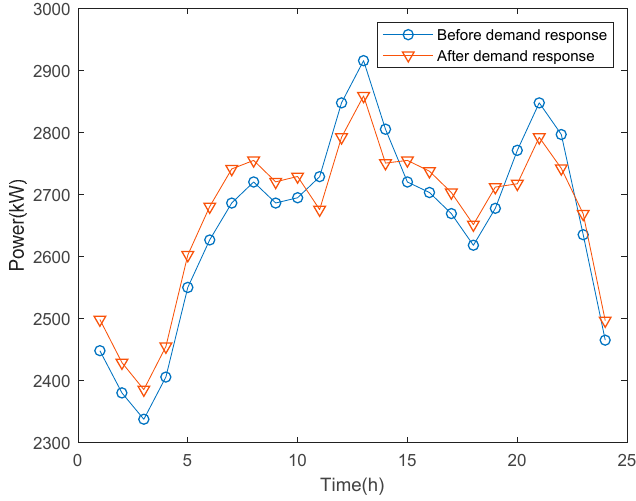
Figure 4. Load curve before and after demand response.